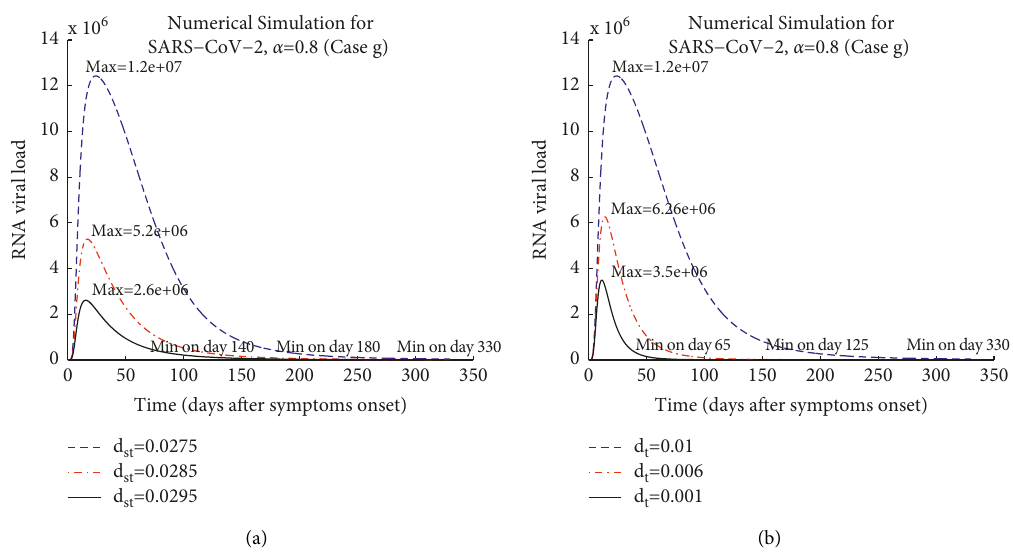
Figure 11: RNA viral load based on changing of d